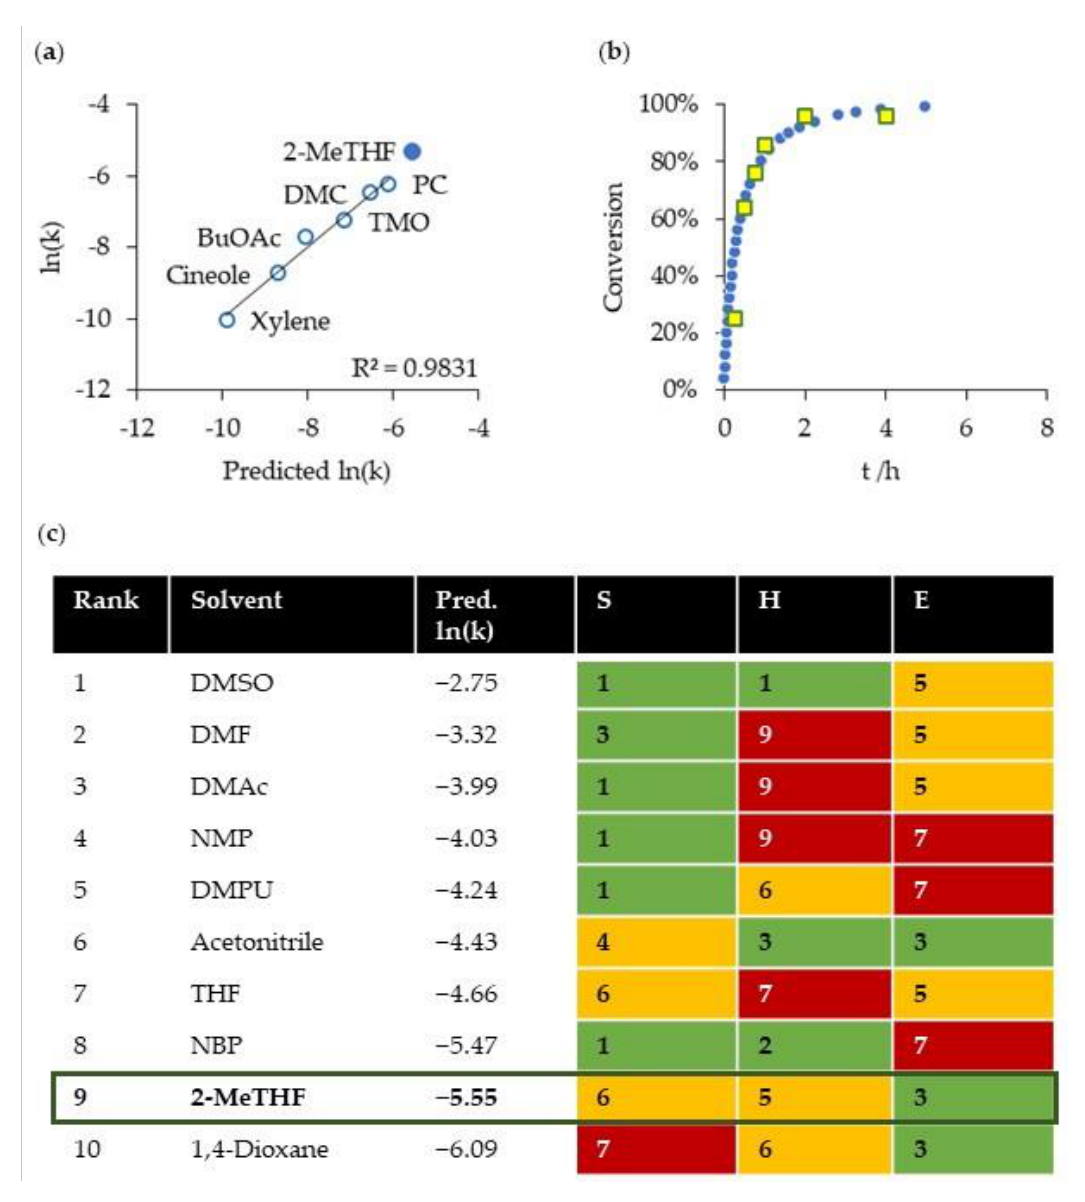
Figure 4. Solvent optimization for a Michael addition. ( a ) Linear solvation energy relationship calculated prior to experiment in 2-methyltetrahydrofuran (2-MeTHF), with data for 2-MeTHF added (solid fill data point); ( b ) Blue (circular) data points representing predicted conversions and yellow (square) data points represent experimental data for the optimized reaction conditions; ( c ) Solvent selection table obtained from the reaction optimization spreadsheet. Bio-based 2-MeTHF is emphasized in the box. Other abbreviations: DMSO, dimethyl sulfoxide; DMF, N , N -dimethyl formamide; DMAc, N , N -dimethyl acetamide; NMP, N -methyl pyrrolidone; DMPU, dimethyl propylene